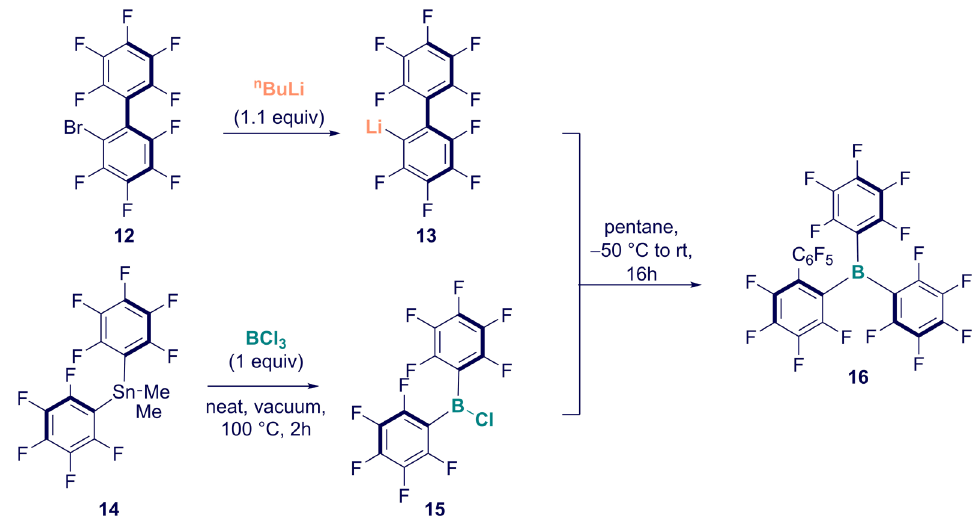
Scheme 4. Synthesis of one of the simplest heteroleptic borane: B(C 6 F 5 ) 2 (2-(C 6 F 5 )C 6 F 4 ) 16 . Soós research group performed the synthesis of other interesting heteroleptic boranes bearing chlorinated and fluorinated aryl rings 21 as shown in Scheme 5. The dihalobenzene derivatives 17 were reacted with n-butyl lithium and trimethyl borate, affording boronic acids 18 . They were then converted into the potassium trifluoroborate salt 19 , that could be reacted with Grignard reagents bearing different aryl frameworks to form the desired heteroleptic boranes. These boranes have the great advantage of being moisture tolerant thanks to the steric hindrance of the chlorine atoms which prevent water from binding to the boron centre [27].